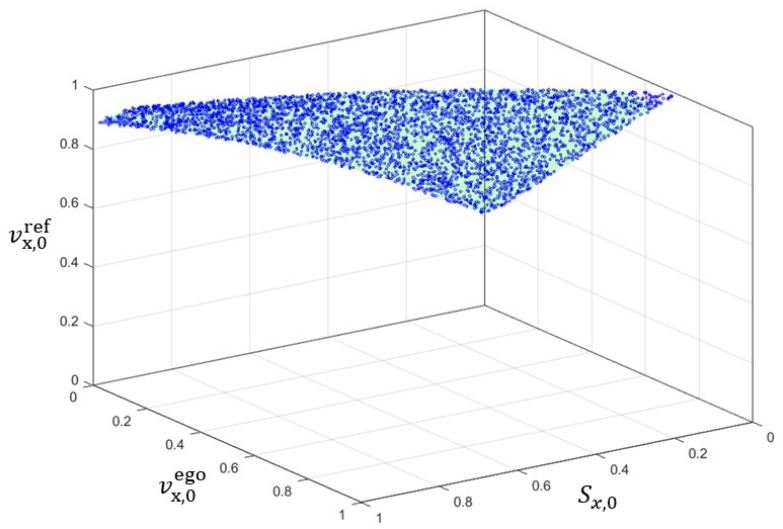
Figure 13. The performance boundary and the candidate scenarios on it. A total of 99.87% of them are found to be boundary scenarios. The mean distance between boundary scenarios and their nearest adverse scenarios is 0.0057, much smaller than the threshold of 0.02.